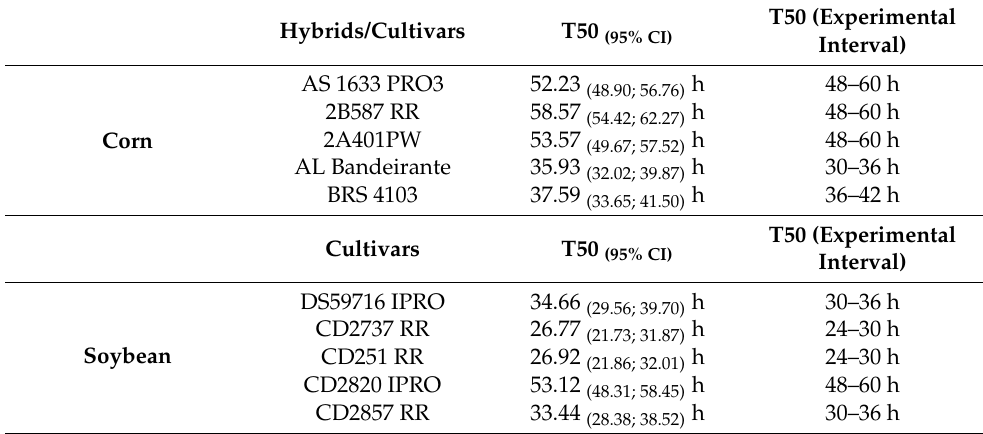
Table 5. Estimates of the T50 obtained from the equations in Table 4 and the experimental interval in which the T50 is